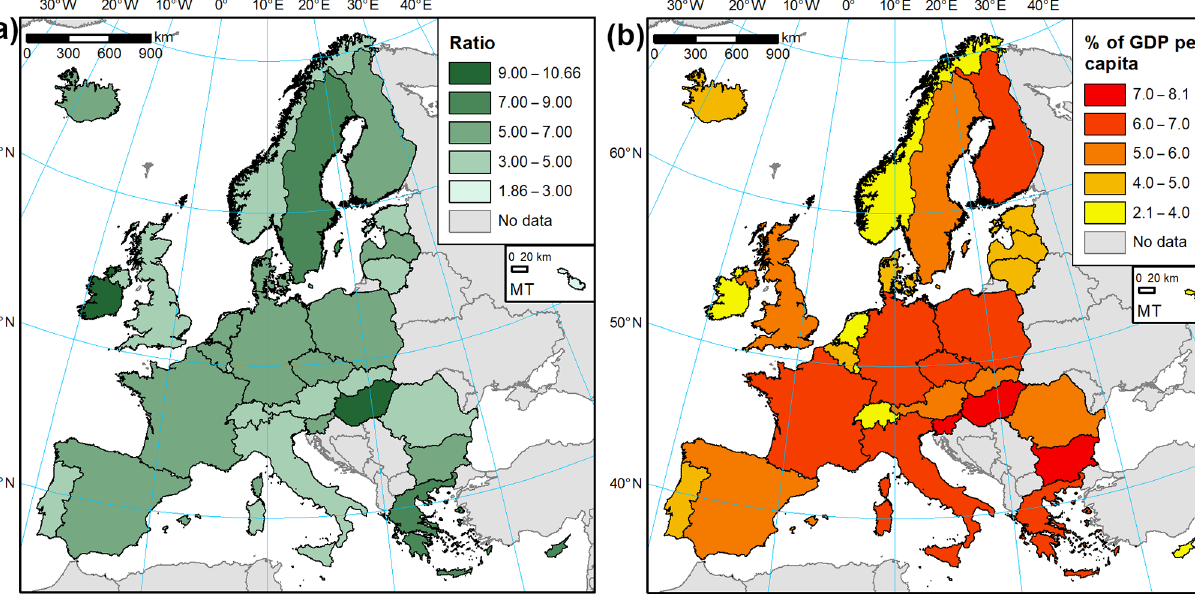
Figure 10. (a) Ratio between average building structure and household content value per square metre, 2017; (b) total residential assets (building and contents) as a percentage of GDP per capita, 2017. Country boundaries from EuroGeographics (Eurostat,